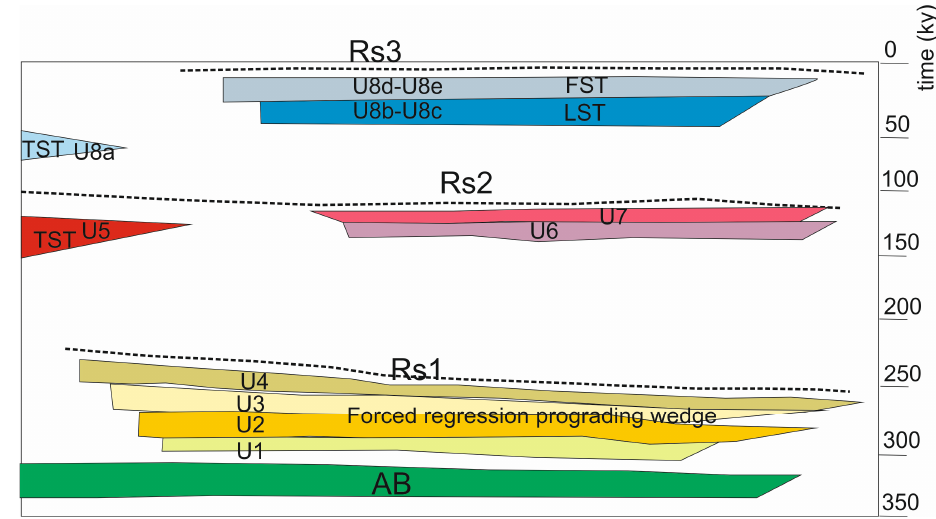
Figure 7. Qualitative chronostratigraphic diagram related to the scheme of stratigraphic relationships of Figure 6, constructed in order to improve the duration of the depositional sequences in the Salento continental shelf. White zones indicate submarine and/or subaerial depositional and/or erosional hiatuses. In this diagram, the age of the sequences and of the ravinement surfaces RS1, RS2 and RS3 has been constrained by the correlation with the curves of isotopic stratigraphy reported by Aiello and Budillon [10].